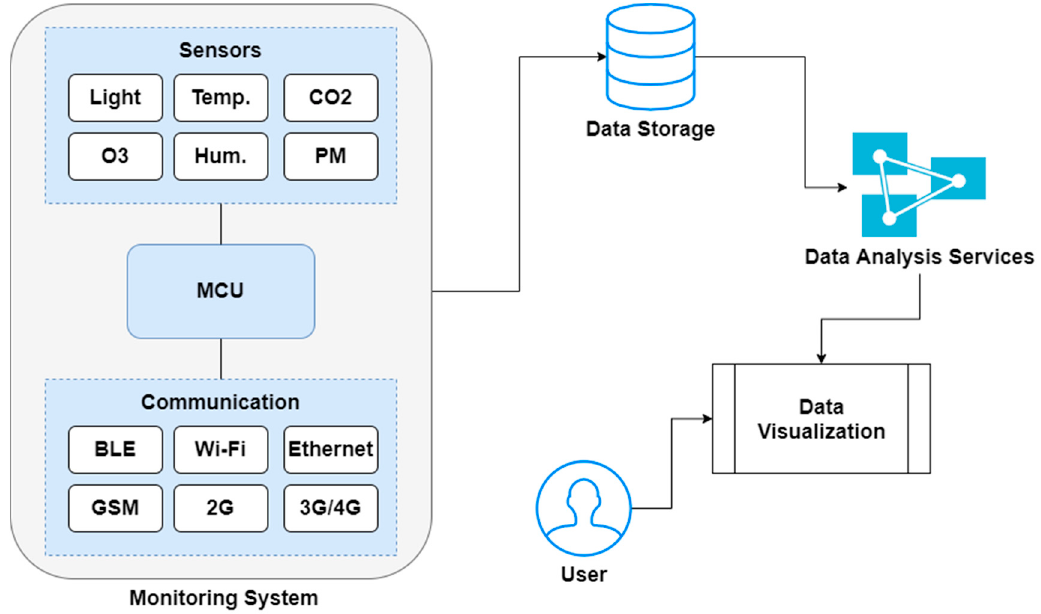
Figure 1. General architecture of Internet of Things (IoT)-based IAQ monitoring systems.